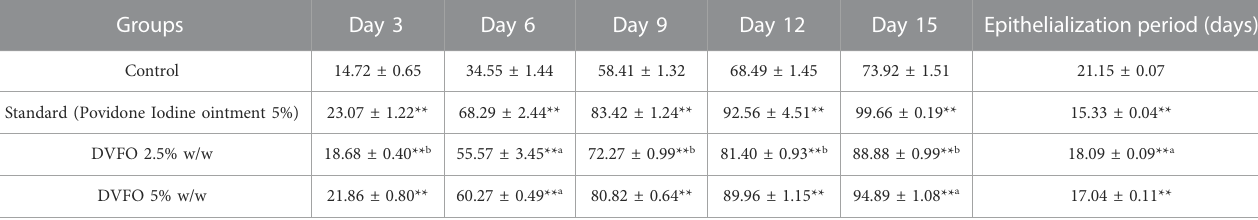
TABLE 2 The effect of DVFO on the percentage wound contraction in excision wound.